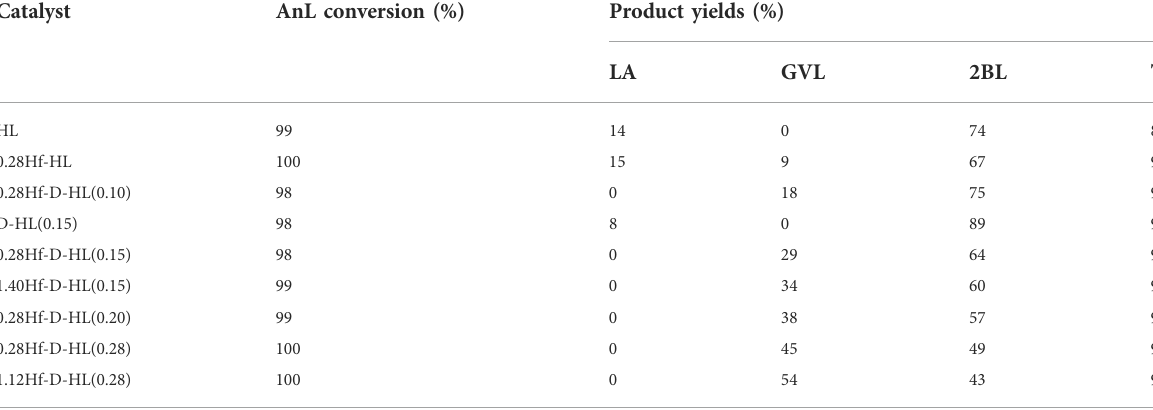
Catalyst AnL conversion (%) Product yields (%)